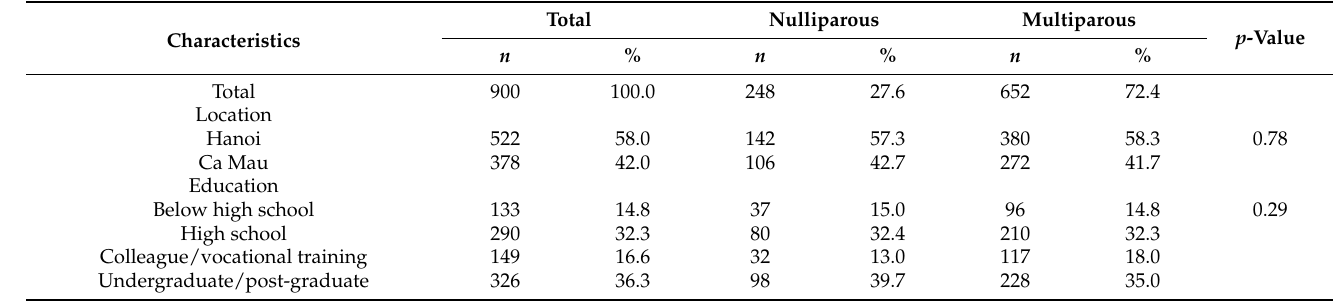
Table 1. Sociodemographic and maternal